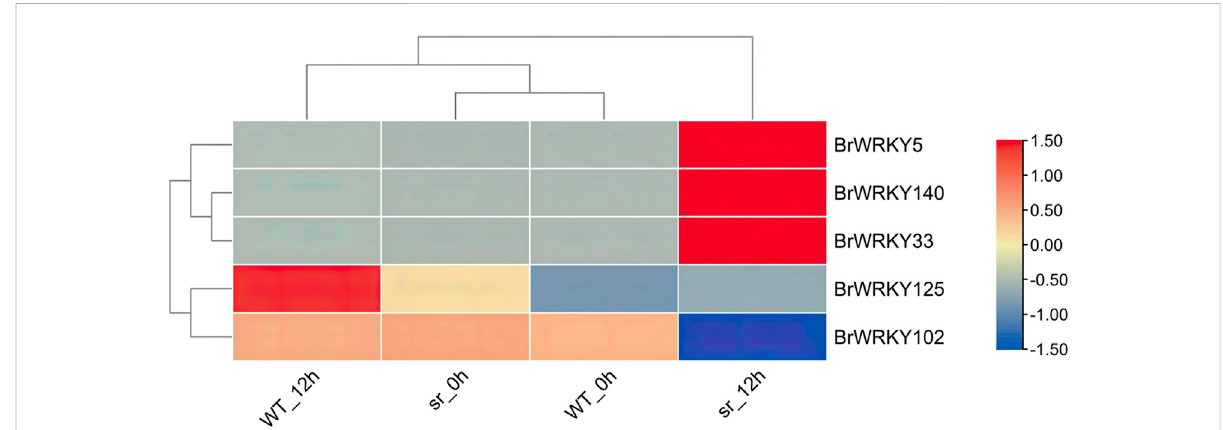
FIGURE 5 HeatmapofdifferentialexpressionofBrWRKYsbetweensusceptibleWTandresistant